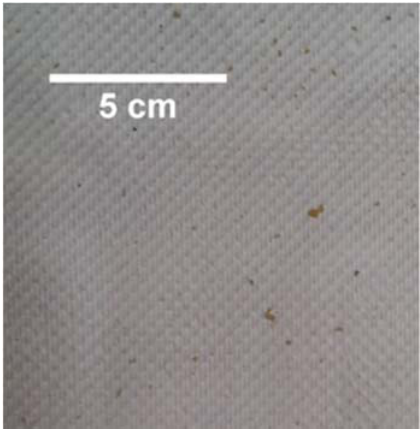
Figure 9. Image of the hydrophilic-coated hydrophobic PTFE membrane after testing with textile wastewater. Table 3. Retentate and permeate quality of the hydrophilic-coated hydrophobic PTFE membrane. Parameter Retentate (before Cleaning) Permeate (before Cleaning)